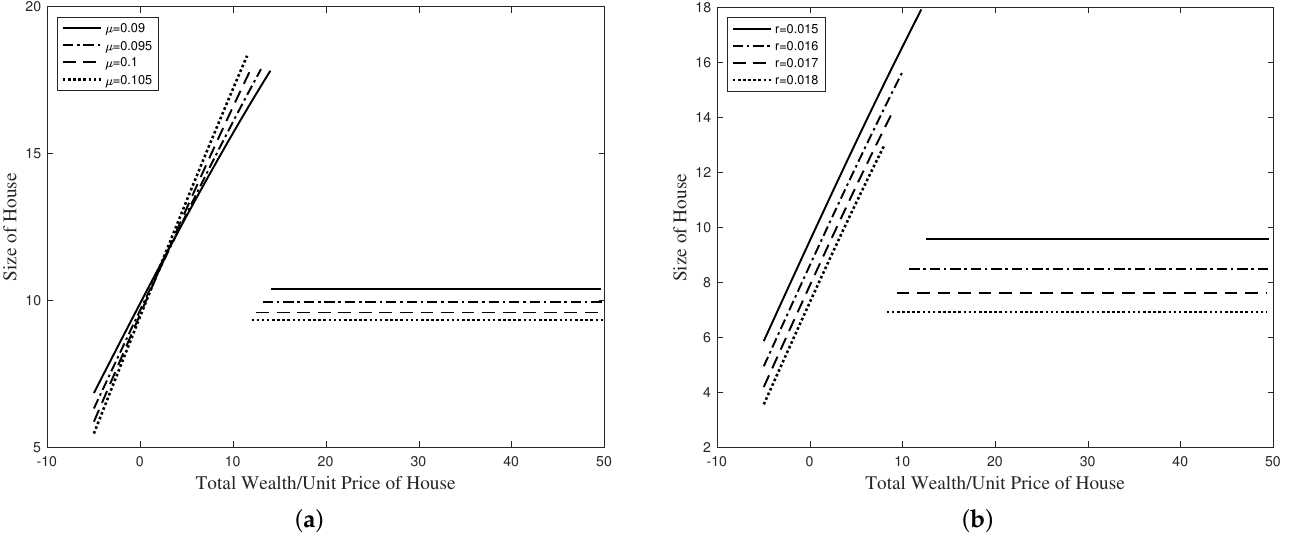
Figure 1. Optimal housing policies with changes in financial market. ( a ) Expected return of risky asset, µ . ( b ) Risk-free rate, r